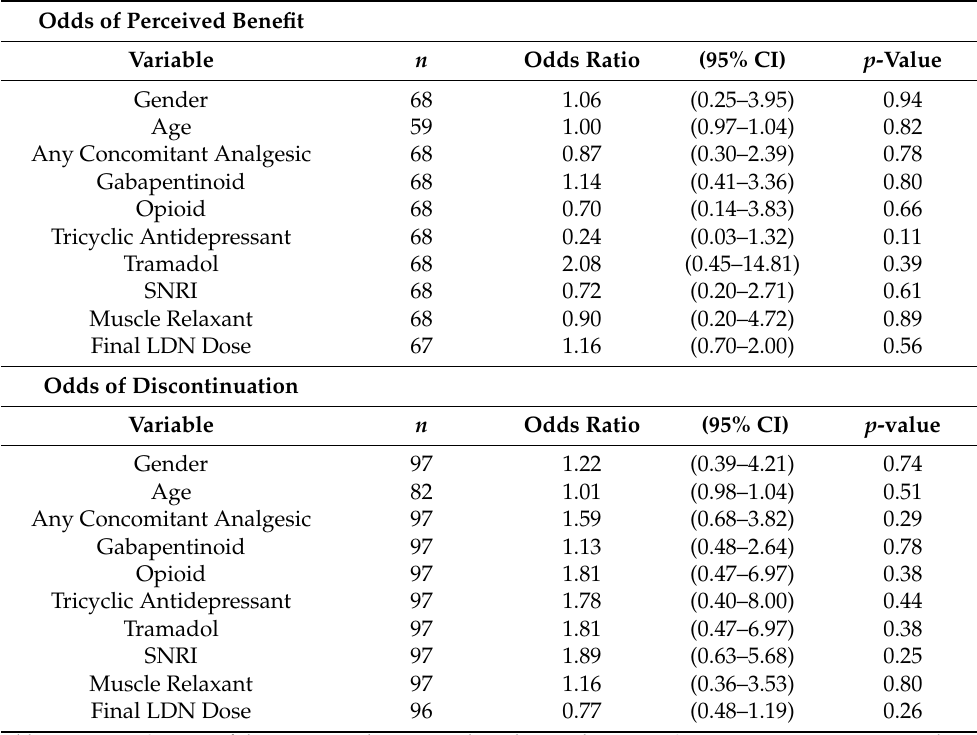
Table 4. Univariate Binomial Models.